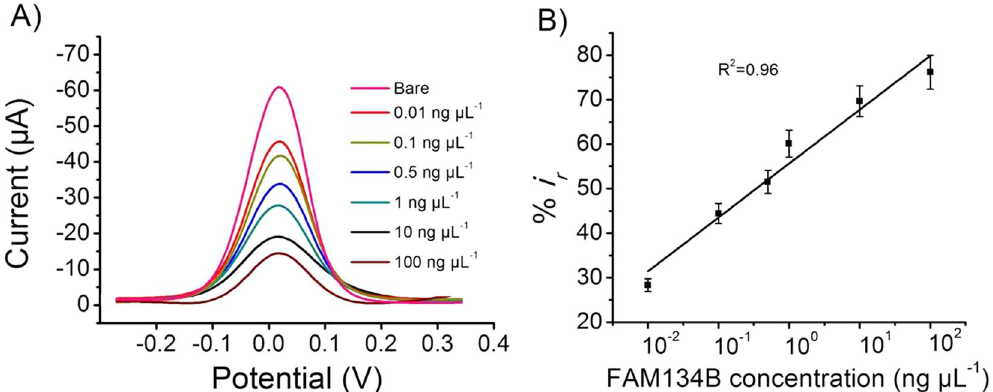
Figure 4. Assay performance. ( A ) Change of the DPV responses at the immunosensing surface after incubation with designated concentrations of FAM134B protein. ( B ) Corresponding relative current change-concentration curve. Each data point represents the average of the three separate trials ( n = 3) and error bars represents the standard deviation of measurements within